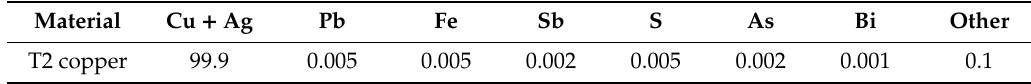
Table 1. The chemical composition of T2 copper (wt %).